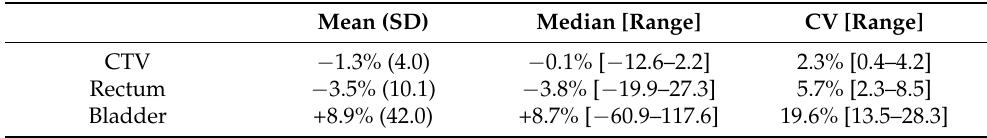
Table 2. Mean, standard deviation (SD), median, and range of percentage differences in CTV, rectum, and bladder volumes between daily fraction CBCTs and planning CTs. The values were averaged over the means of each patient for CTV and over all 56 fractions for rectum and bladder. Average intrapatient CV and range of the structure volumes are also reported.